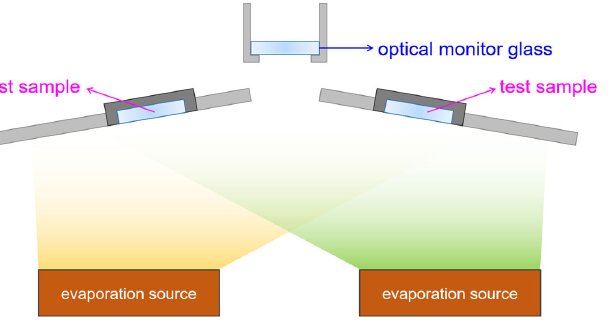
Figure 11. Schematic drawing for showing location differences among test samples and optical monitoring sensor.